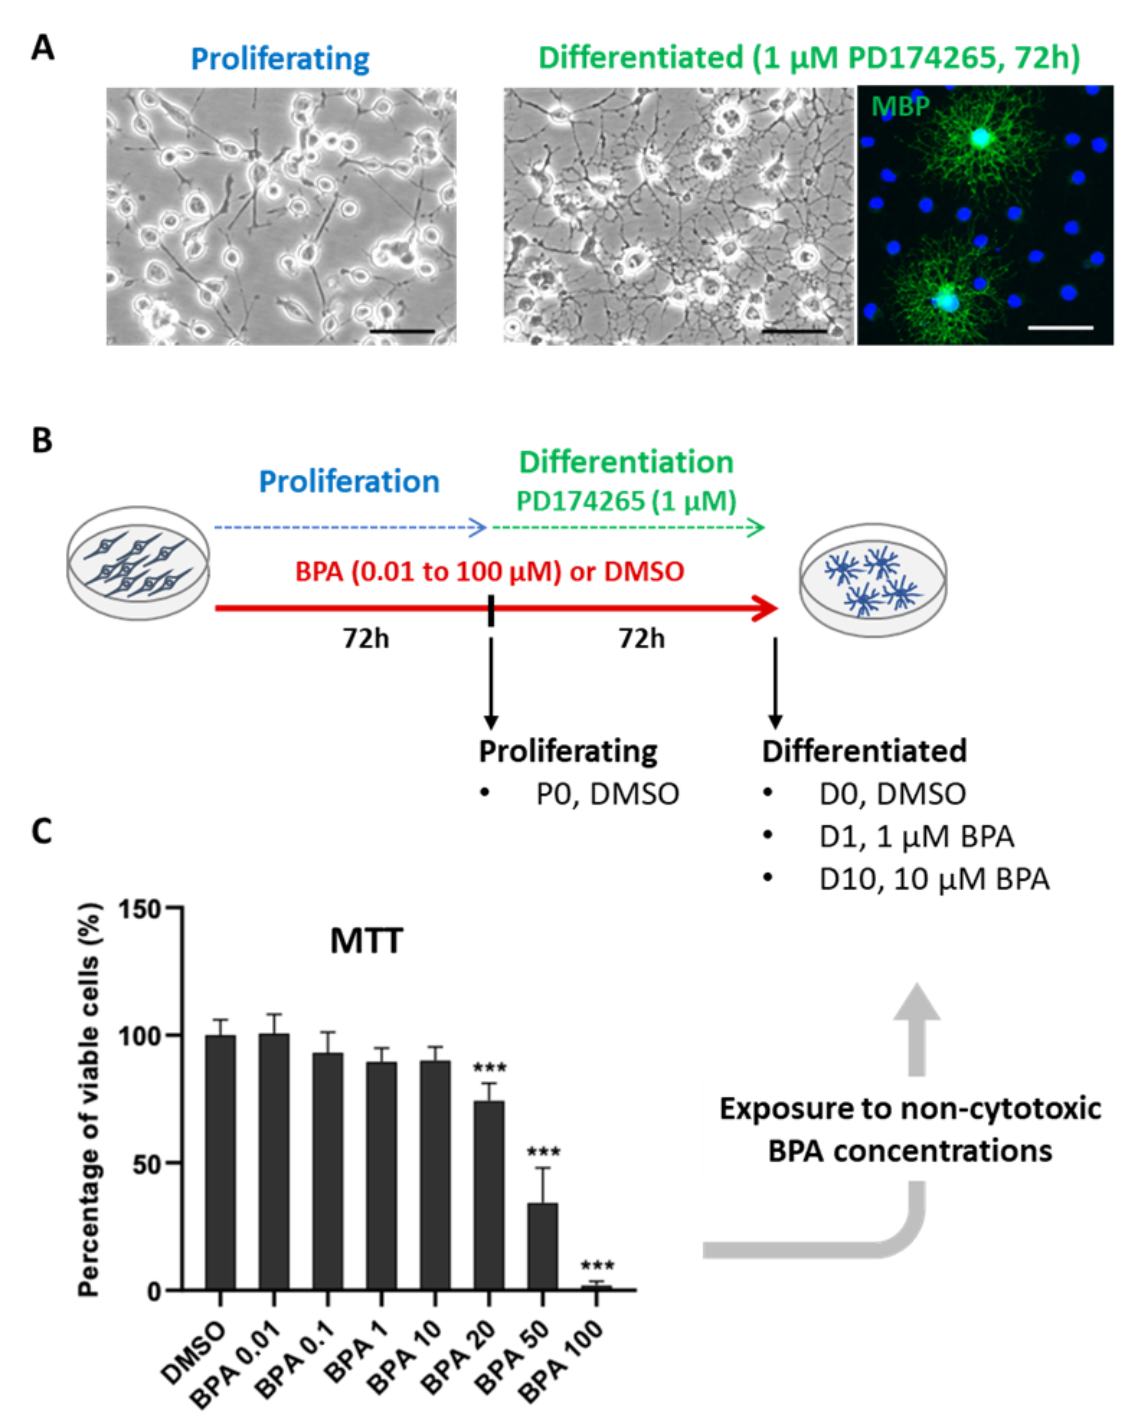
Figure 1. Oli-neu morphology, protocol of exposure to BPA and viability assay: (( A ), left panel ) Proliferating Oli-neu cells displaying bipolar morphology; (( A ), right panel ) Oli-neu cells displaying ramifications and positive MBP immunostaining in a subset of cells after 72 h of differentiation induced by pharmacological agent PD174265 (1 µM), scale bars 50 µM; ( B ) protocol of exposure to bisphenol A (BPA) for 72 h of proliferation and 72 h of differentiation. P0— proliferating cells, D0—differentiated control cells, D1—differentiated cells exposed to 1 µ M BPA, D10—differentiated cells exposed to 10 µ M BPA; ( C ) cell viability determined by MTT assay ( N = 5), results are expressed as mean ± SD percentage of viable cells as compared with the DMSO control (one-way ANOVA and Dunnett multiple comparison post-test, *** p <